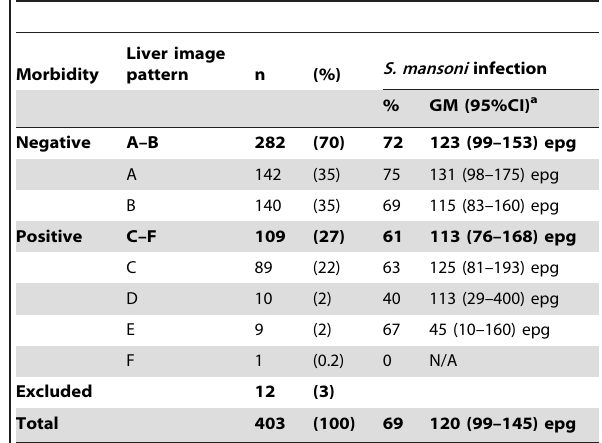
Table 2. Schistosoma mansoni -associated hepatic fibrosis and S. mansoni infection in the two co-endemic communities